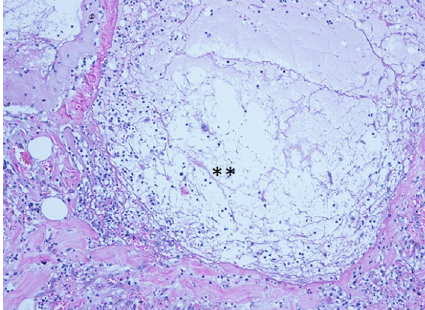
Figure 1: Amorphous material resembling amyloid ( ∗ ) in submucosal tissue. H and E stain × 10.